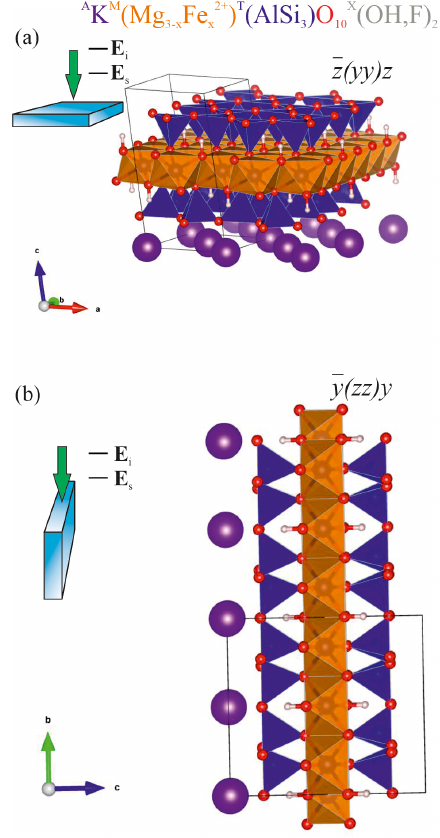
Figure 1. Sketch of the scattering geometries along with fragments of the atomic structure of biotite in the corresponding orientations: (a) horizontal orientation with the cleavage plane ⊥ to the laser beam direction and || to E i and (b) vertical orientation of the biotite crystal with the cleavage plane || to laser beam direction and ⊥ to E i . TO 4 tetrahedra are in blue; MO 6 octahedra are in orange; A- site cations are in purple; O 2 − anions are in red; H + cations are in pink-whitish. VESTA software package (Momma and Izumi, 2008) was used to plot the atomic